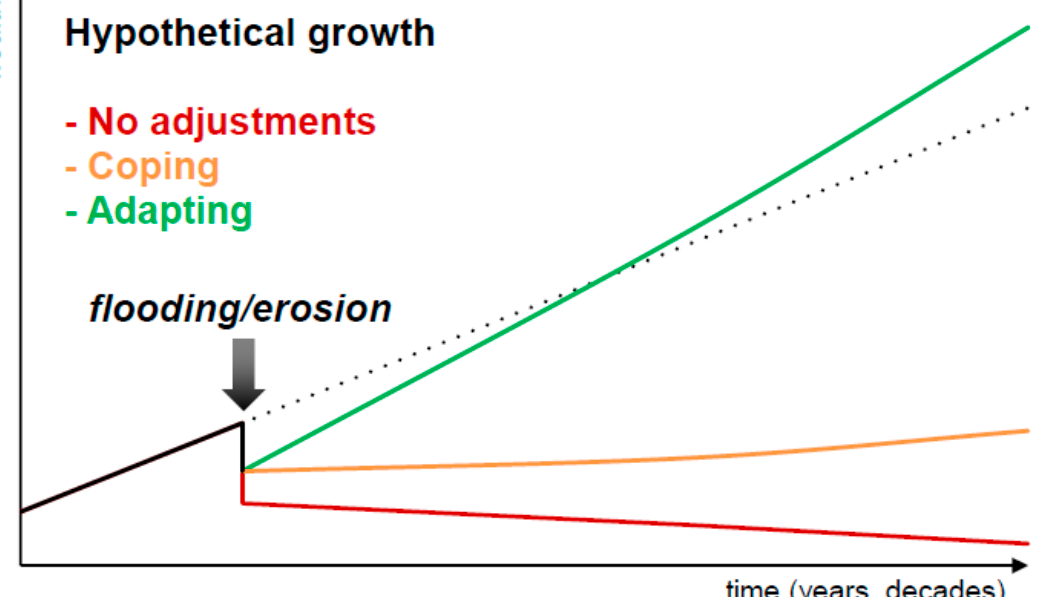
Figure 9. Coping or adapting? Deviation from a hypothetical trajectory of socio-economic growth (black line) caused by flooding and erosion, in case of: (i) no adjustments (red line), (ii) coping (orange line), and (iii) adapting (green line).